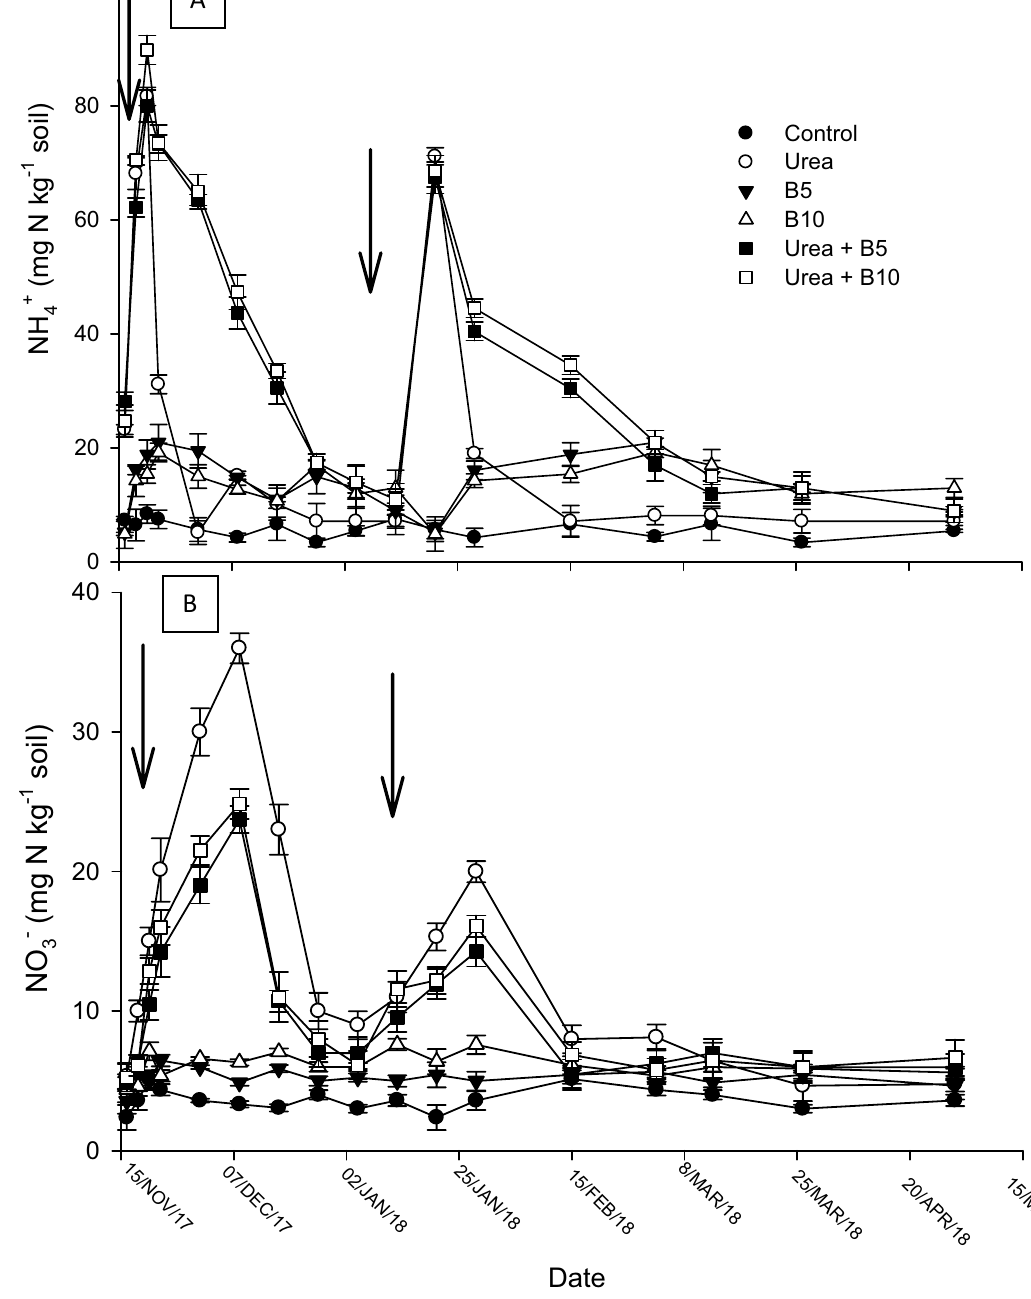
Figure 2. Soil NH 4+ and NO 3- (0–10 cm depth) in soils amended with sole urea or urea + biochar treatments. Solid arrows show time of N